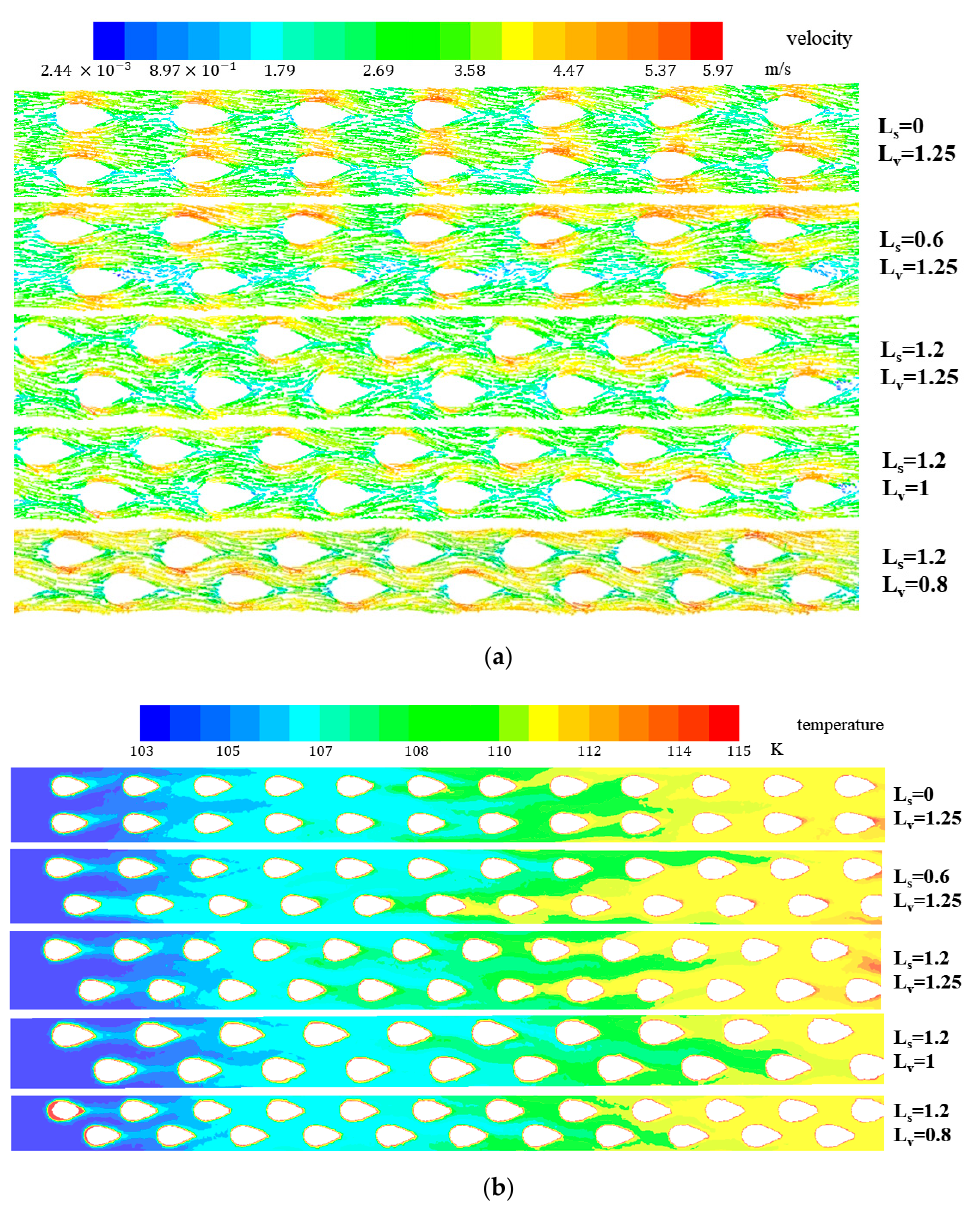
Figure 7. Velocity vector and temperature distribution: ( a ) velocity vector distribution near the outlet; ( b ) temperature distribution near the inlet.